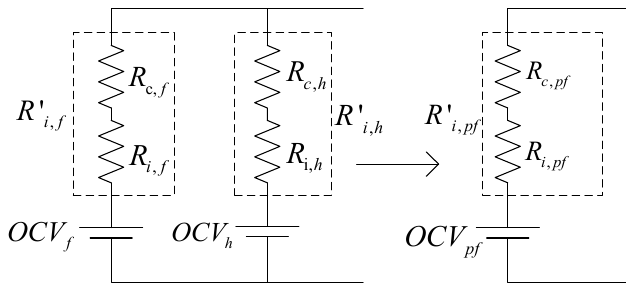
Figure 2. ECM of PCBG with two batteries.